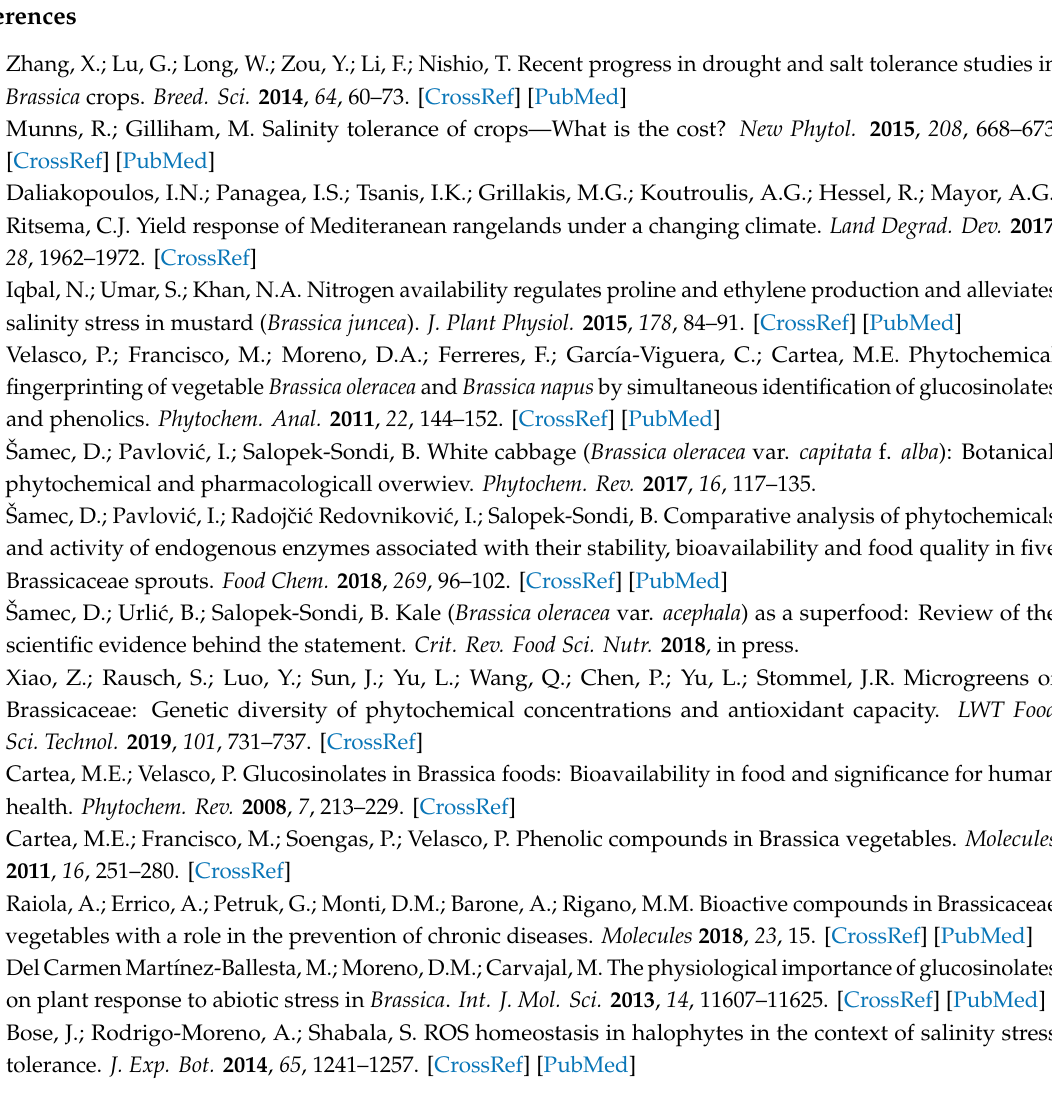
Figure S1: Representative UPLC–MS / MS chromatograms (A–J) of conjugated phenolic acids in a kale ( Brassica oleracea var. acephala ) extract: salicylic acid (1), ferulic acid (2), sinapic acid (3), 4-coumaric acid (4), syringic acid (5), ca ff eic acid (6), vanillic acid (7), 4-hydroxybenzoic acid (8), gallic acid (9), protocatechuic acid (10). Table S1: Specific metabolites in Brassica seedlings upon salinity stress (0–200 mM NaCl). Table S2: Correlation matrix Table S5: Squared cosines of the variables. Table S6: Squared cosines of the